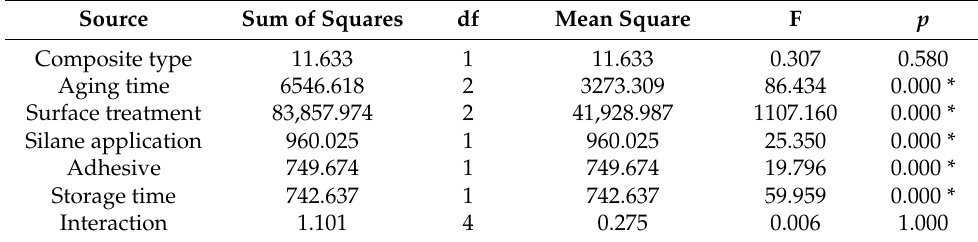
Table 2. The ANOVA results for microtensile bond strength